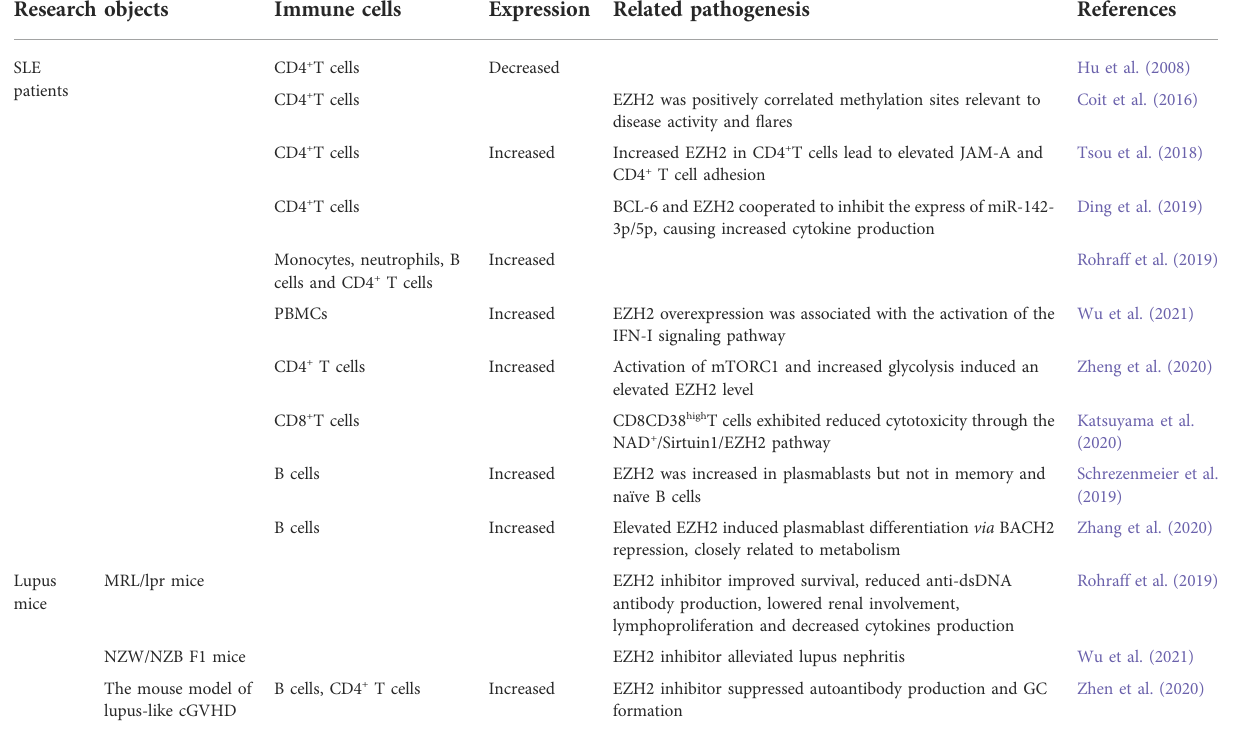
TABLE 3 The role of EZH2 in immune dysregulation of SLE